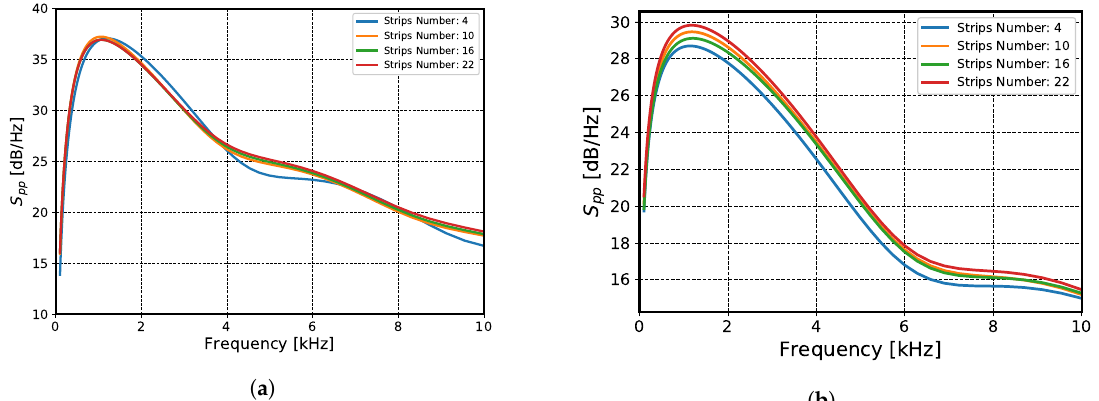
Figure 9. Convergence study on the number of strips to use in order to acceptably discretize the noise sources on the blade span: ( a ) leading-edge noise prediction case, ( b ) trailing-edge noise prediction